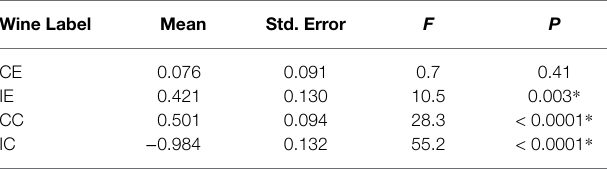
TABLE 4 | Mean of the PCN amplitudes for each bottle/label averaged across sessions from 160 to 200 ms, standard errors of the mean, and results of F tests as deviation from “0.”